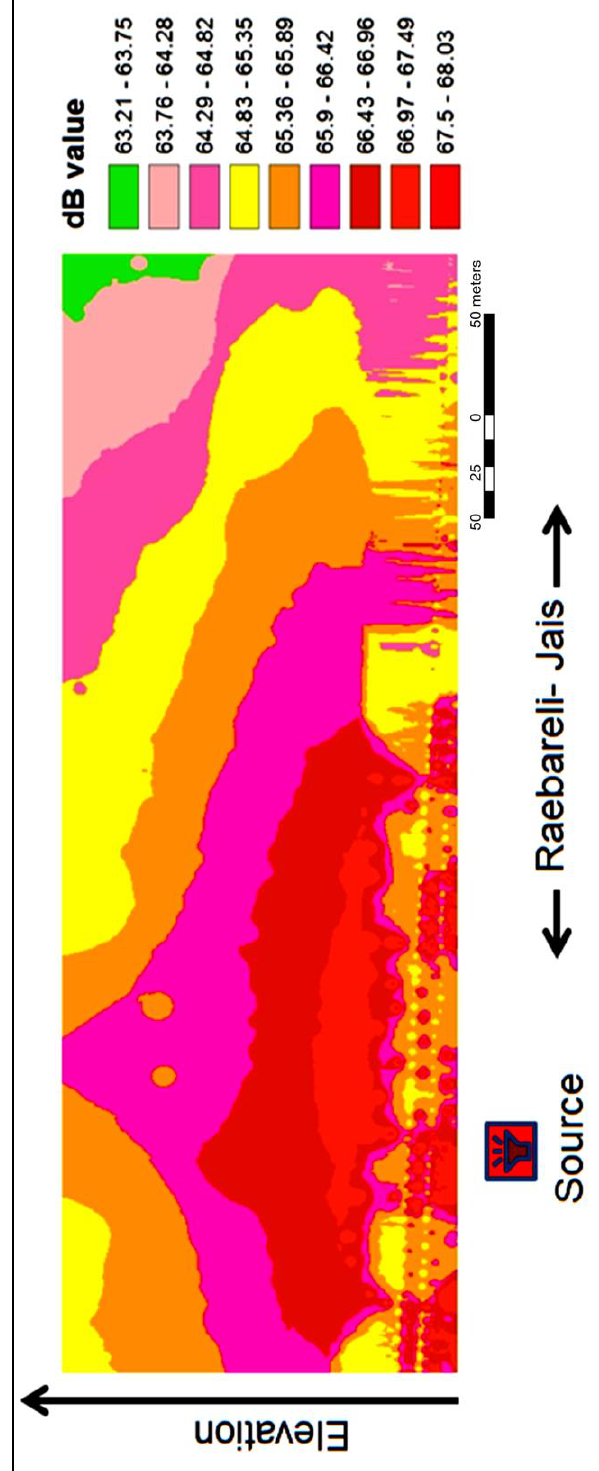
Figure 8. The Detailed and Accurate Prediction of Noise on the Facade of Academic Building -AB2 Building. The variation of Noise Levels on the Vertical wall of AB2 is how it spared this map is generated using high-resolution LiDAR data. This is the Accurate Model Prediction where high-resolution geospatial data (LiDAR) data is taken for DEM Generation and all attenuation were considered such as barrier attenuation and